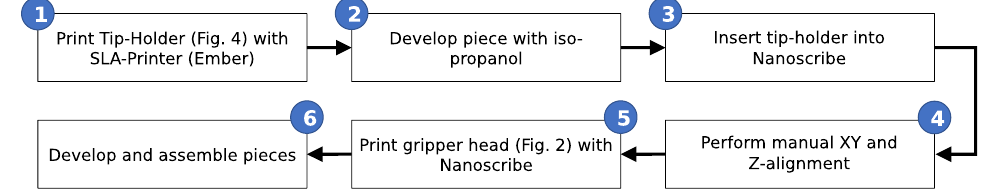
Figure 5. Flow chart for the manufacturing of the two-scale 3D printed capillary gripper.